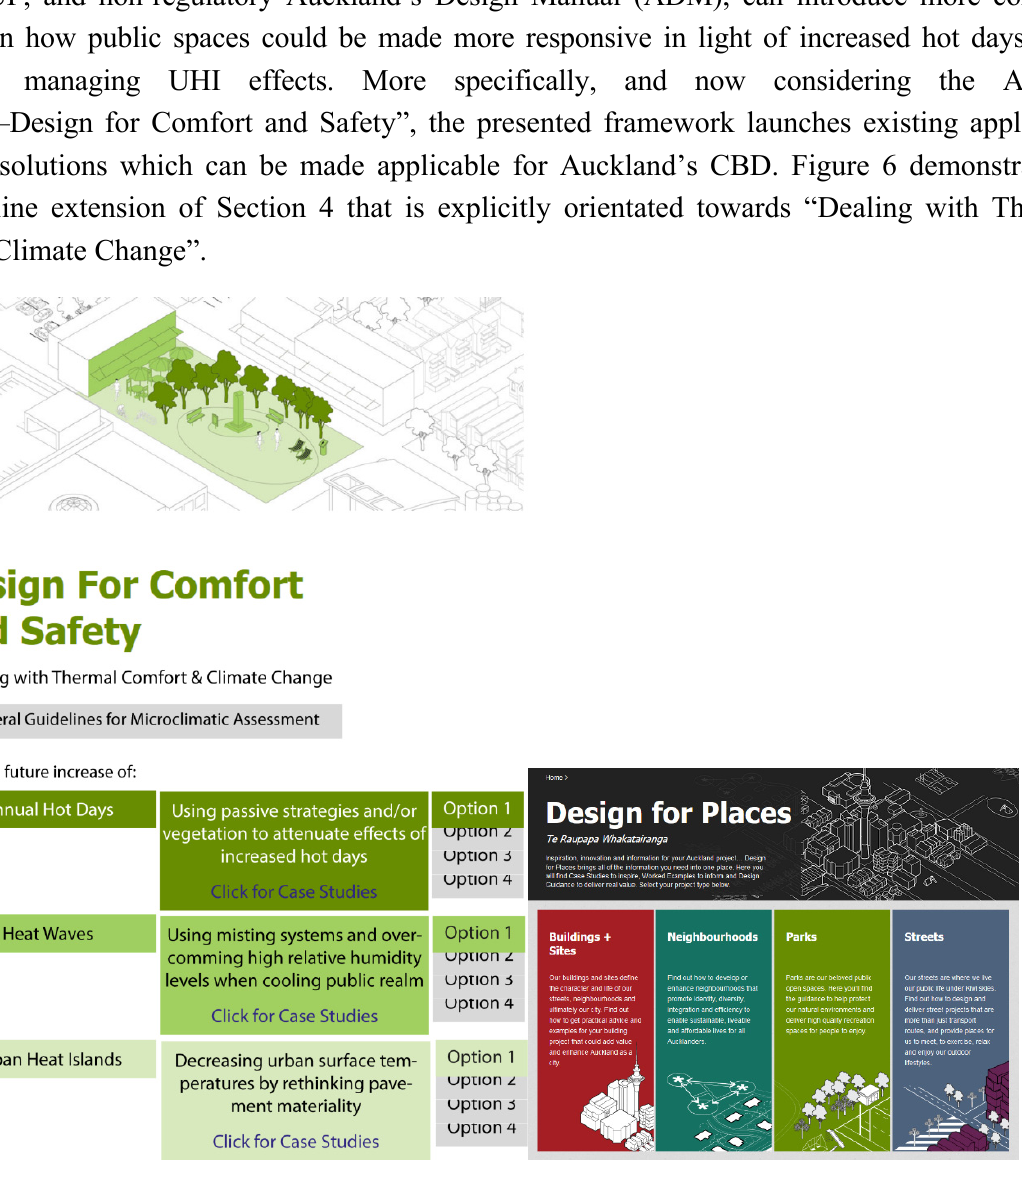
Figure 6. Extending the ADM through the incorporation of the